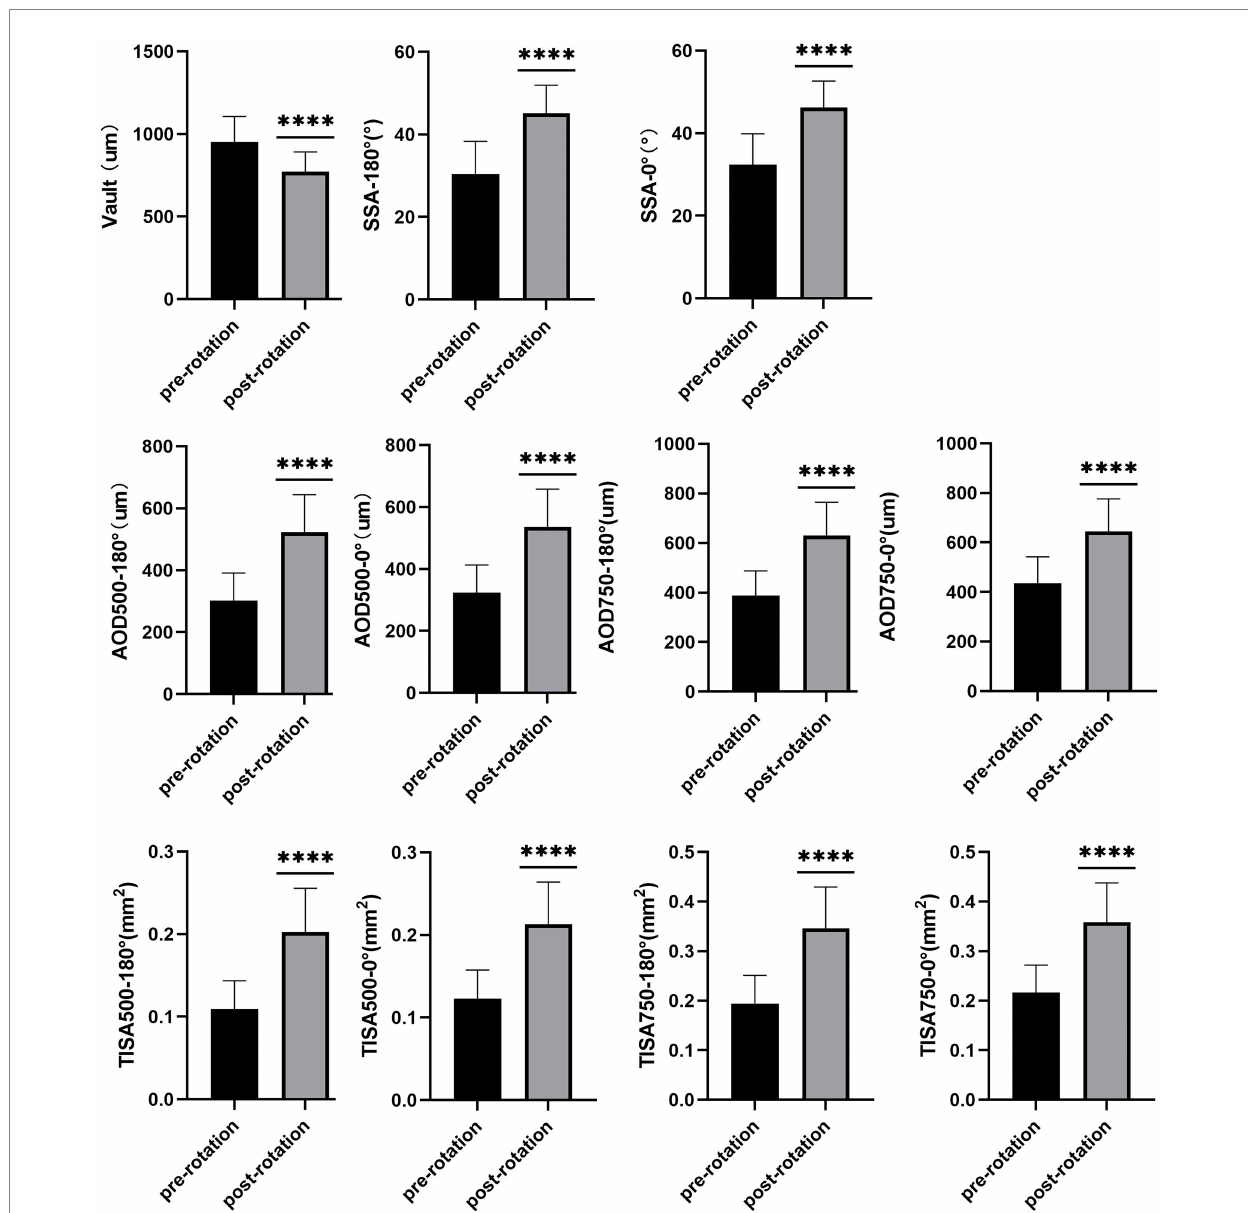
FIGURE 1 The mean vault value had declined significantly 1-week post-rotation ( p < 0.001). The SSA, AOD500, AOD750, TISA500, and TISA750 at 180 ° and 0 ° had increased significantly accordingly (all p < 0.001). **** means that the p <